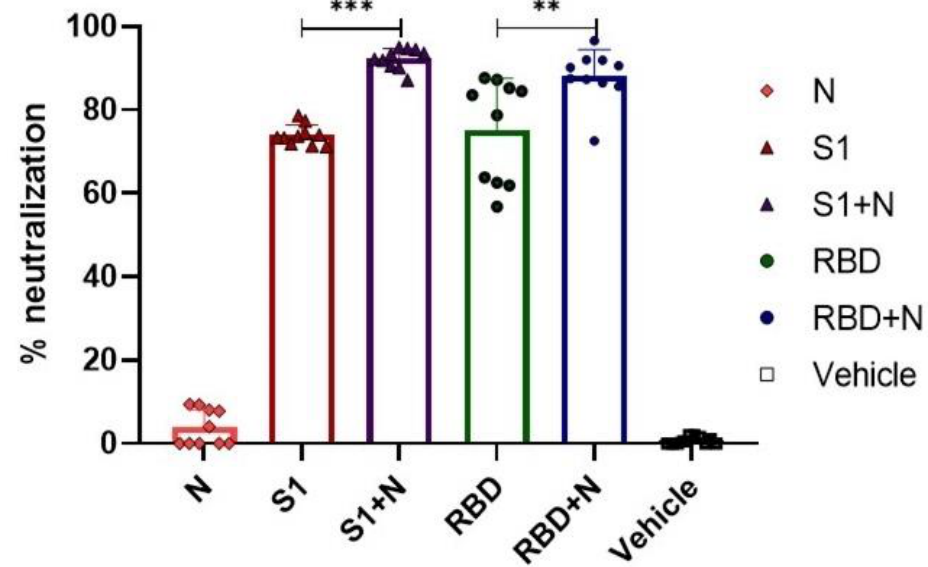
Figure 5. Combination with N protein results in higher levels of neutralizing antibodies in mice. The serum-neutralizing activity of immunized mice was evaluated using a simulated neutralization assay. Each bar represents the percentage of neutralizing activity observed in the groups immunized with indicated proteins. Sera were diluted 1:20. Student’s t -test was used; bars represent the mean ± SD. * p < 0.05, ** p < 0.01, *** p < 0.001. p ≤ 0.05 was considered statistically significant. Prism v.8 software was used for statistical analyses (GraphPad Inc., La Jolla, CA, USA).